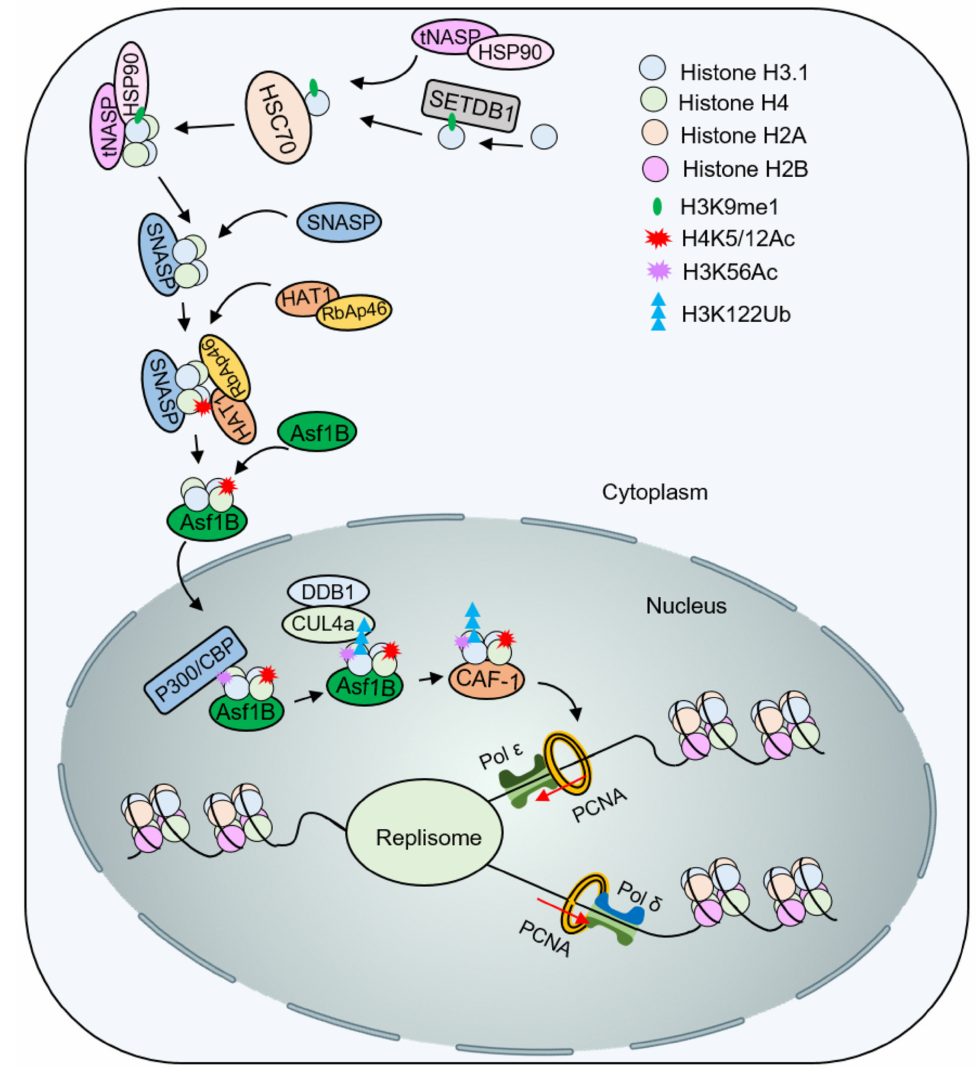
Figure 4. Histone modifications function in nucleosome assembly in mammals. After H4 acetylation on K5 and K12 by HAT1, Asf1 and Importin-4 help nuclear import of H3-H4K5/12ac. Subsequently, acetyltransferase p300/CBP catalyzes the acetylation of H3K56 to promote the ubiquitination of H3K122 by Cul4A DDB1 . The modified H3-H4 is presented to the histone chaperone CAF-1 to assemble the